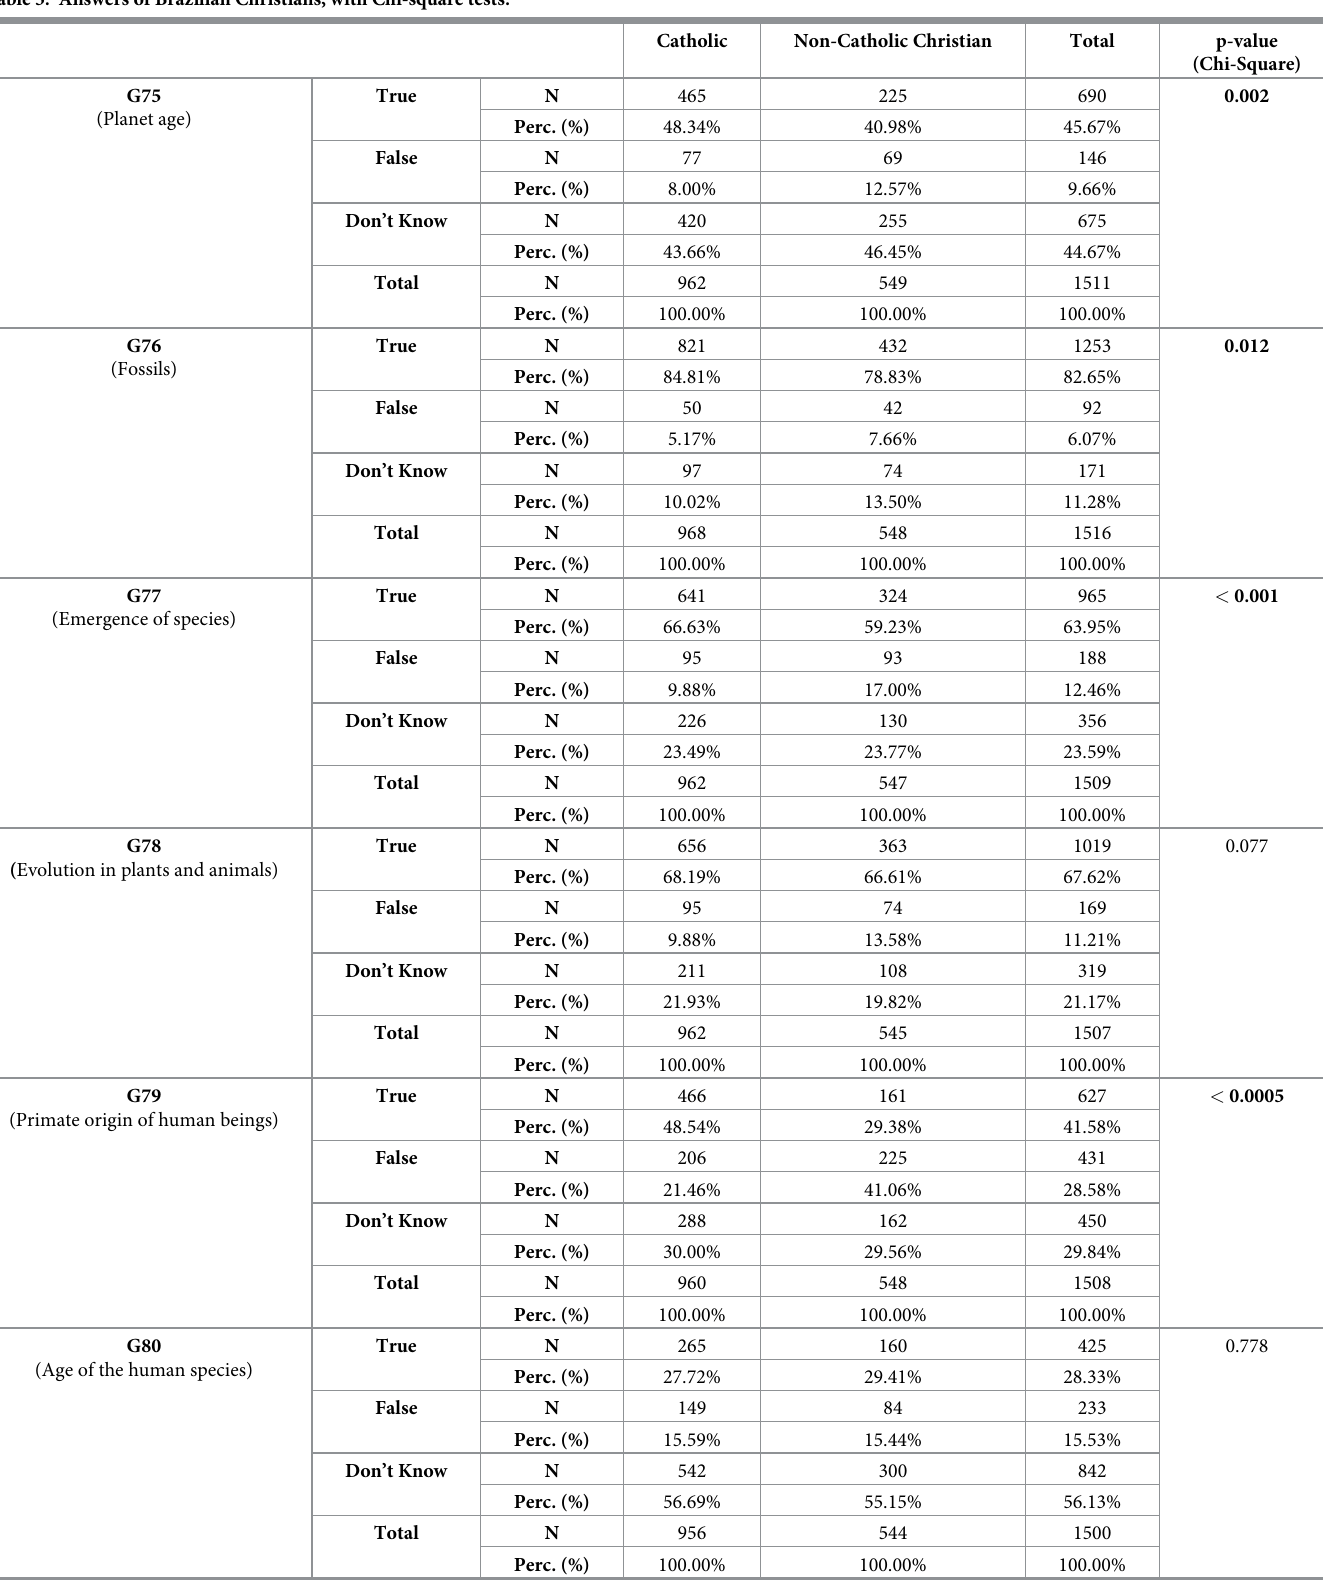
Table 3. Answers of Brazilian Christians, with Chi-square